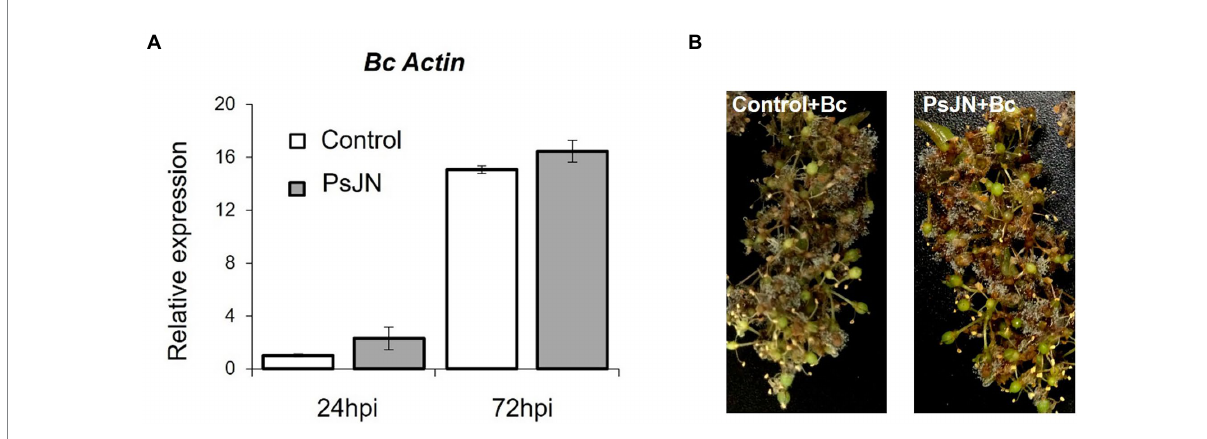
FIGURE 2 Resistance induced by P. phytofirmans PsJN against B. cinerea . (A) Detection of Botrytis in planta by qPCR using primers targeting the Actin encoding gene, at 24 and 72 hpi. (B) Symptoms developed on inflorescences 72 hpi with B. cinerea bacterized or not with